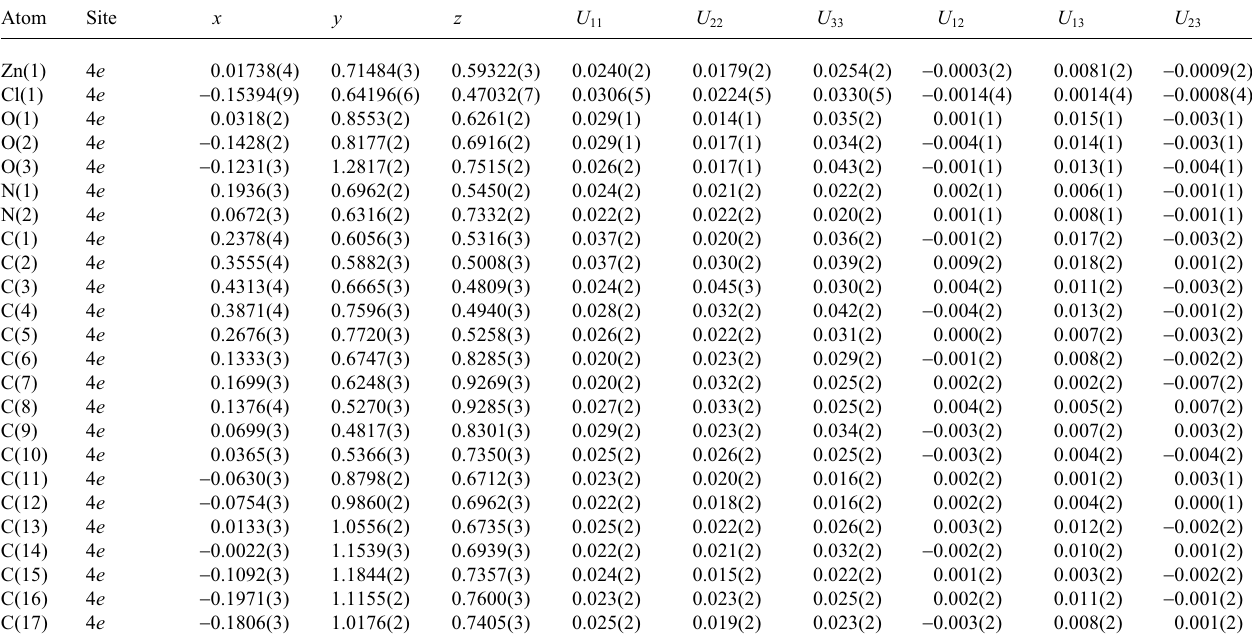
Table 3. Atomic coordinates and displacement parameters (in Å 2 )